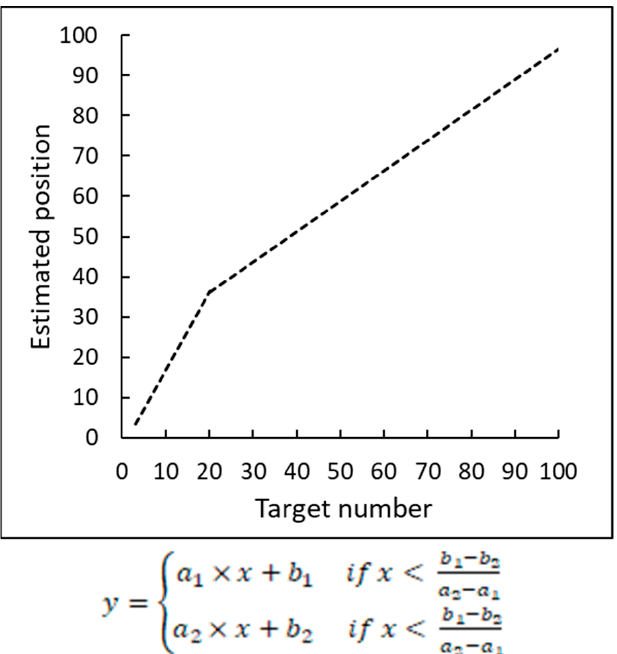
Figure 1. A representative schematic of a curve fitting the two-linear model of Ebersbach et al. [9] with a flexible change point equal to 20. The values of x (cid:101) ( 0, 20 ) correspond to the range of more familiar numbers and are fit by the line of the steeper slope while the values of x (cid:101) ( 21, 100 ) correspond to the range of less familiar numbers and are fit by the line of the less steep slope.